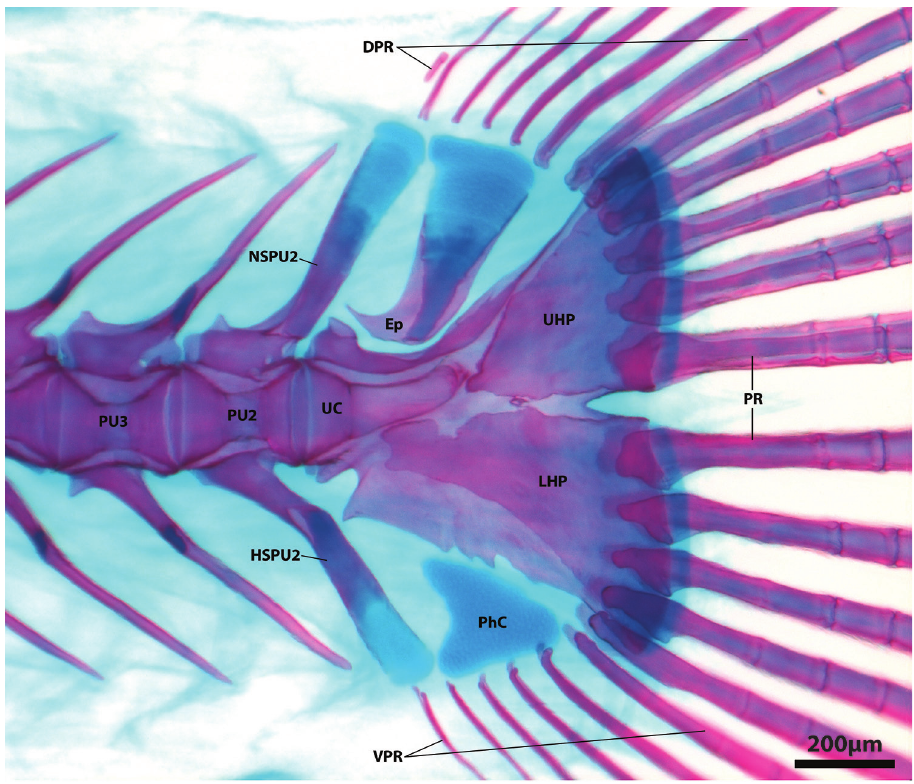
Figure 10. Caudal-fin skeleton (left side, lateral view) of Flexor incus , AIM MA655142, paratype, 20.0 mm SL. Abbreviations: DPR, dorsal procurrent caudal-fin rays; Ep, epural; HSPUS, hemal spine of preural centrum 2; LHP, lower hypural plate; NSPU2, neural spine of preural centrum 2; PhC, parhy- pural cartilage; PR, principal caudal-fin ray; PU2-3, preural centrum 2, 3; UC, ural centrum; UHP, upper hypural plate; VPR, ventral procurrent caudal-fin Papillae of disc region A decreasing in diameter gradually towards outer margin of disc. Papillae of disc region B and C decreasing in diameter towards outer margin of inner disc. Decrease in size of papillae of disc region C abrupt, with papillae of inner row 2–3 times larger than papillae of outer rows. Dorsal postcleithrum a well ossified shield- shaped bone with ~25 long, poorly ossified and distally bifurcated fimbrae (Figure 9B). Ventral postcleithrum well ossified, irregular in shape; approximately equal in size to dorsal postcleithrum (Figure 9B). ~20 long, poorly ossified and distally bifurcated fimbrae restricted to posterolateral margin of ventral postcleithrum; point of fimbrae bifurcation located distally on medial fimbrae, shifting gradually to a more proximal location on lateral fimbrae. A strong articulation between anteromedial edge of ventral postcleithrum and posterior tip of basipterygium (Figs 5B, 9B). Skin associated with last pelvic-fin ray attaching to base of pectoral fin opposite 5 th –6 th lowermost pectoral- fin rays. Skin over base of ventral pectoral-fin rays smooth. Pectoral radials with well-